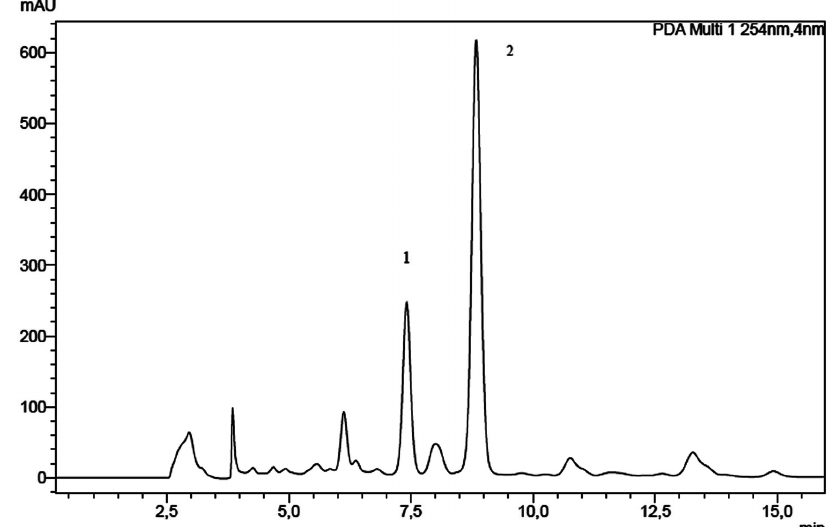
FIGURE 3 - HPLC-DAD (λ=254 nm) separation of the ethyl acetate fraction from Kalanchoe pinnata leaves. The separation was carried out on a Shimadzu LC-20A series, 250 mm x 4.6 mm, 5 µm Shim-pack VP-ODS C18 reverse-phase column (Shimadzu ® ), at flow rate of 1 mL/min. Isocratic elution (25% acetonitrile and water with 0.1% trifluoroacetic acid) in 15